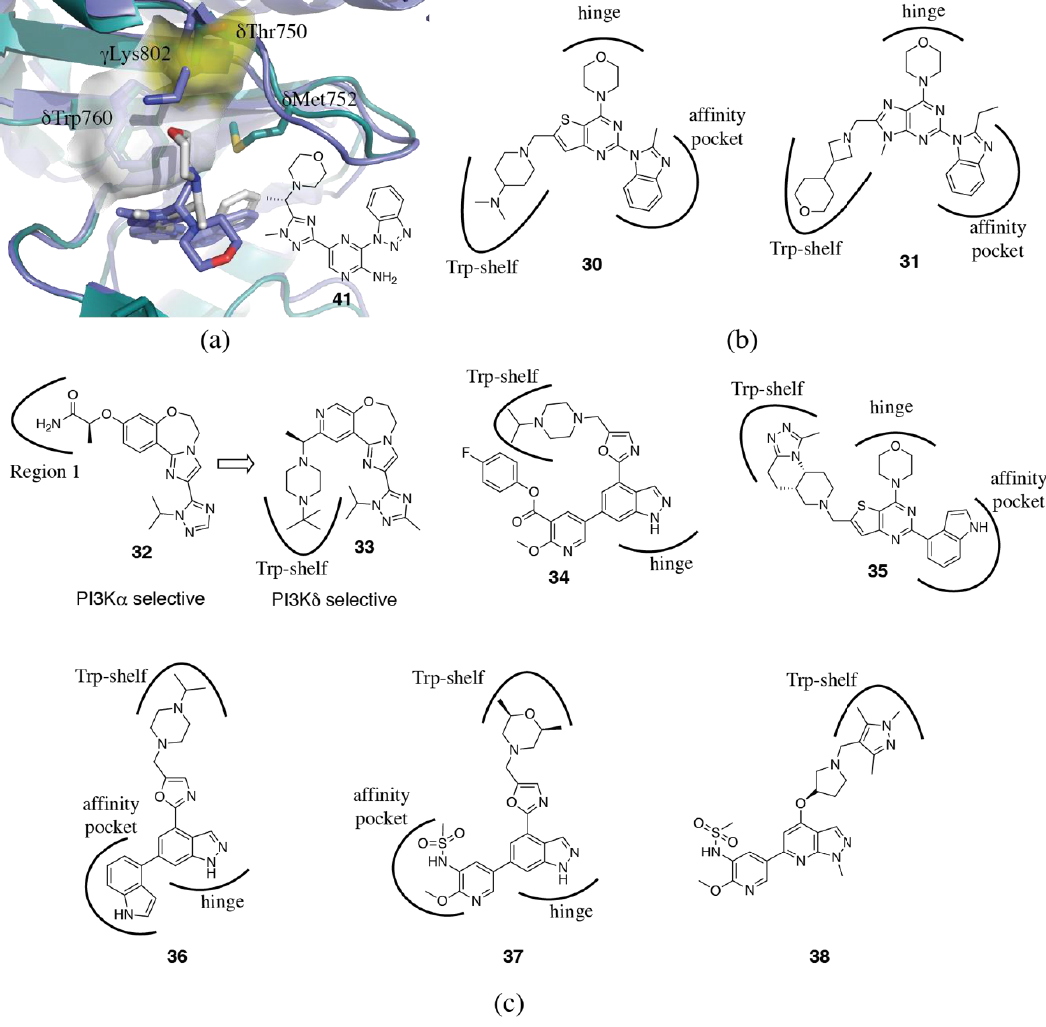
Figure 6. The tryptophan shelf. ( a ) The tryptophan shelf is formed by the exposed surface of δ Trp760 (p110 δ cartoon shown in teal, the surface of δ Trp760 shown in white, PDB ID 5T27) by the small side-chain of δ Thr750 (surface shown in yellow). In p110 γ (slate, PDB ID 5T23), the longer side-chain of γ Lys802 occludes the surface of the tryptophan. The different conformations of 41 bound to p110 δ (inhibitor colored in white) and p110 γ (inhibitor colored in purple) are shown. ( b ) Structures of 30 – 31 . ( c ) Structures of 32 – 38 .